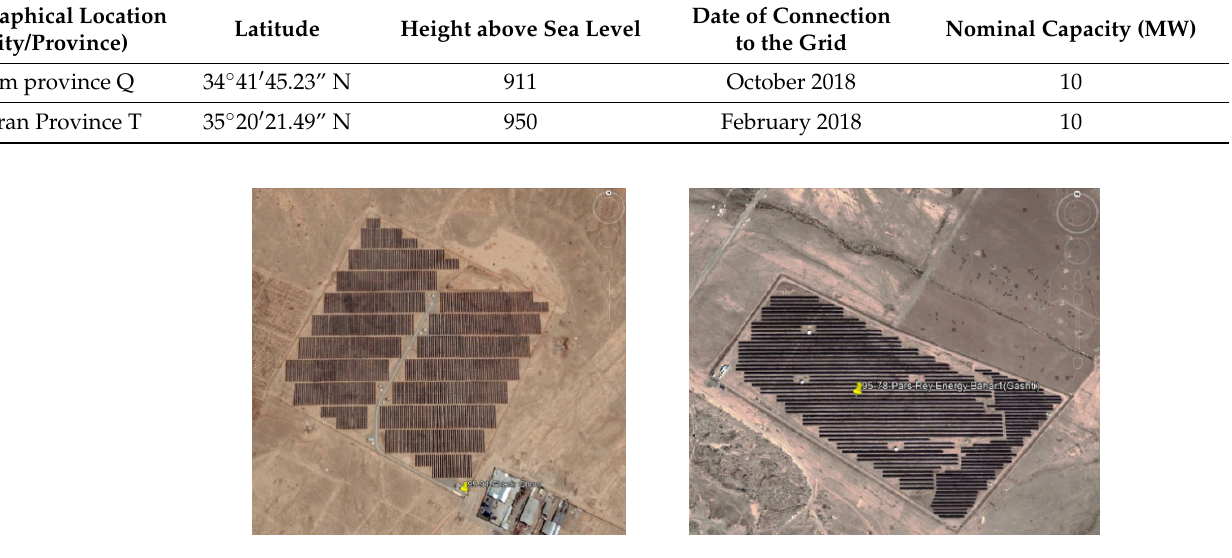
Figure 1. Aerial image of Q power plant in Qom province ( right ) and T power plant in Tehran province ( left ).